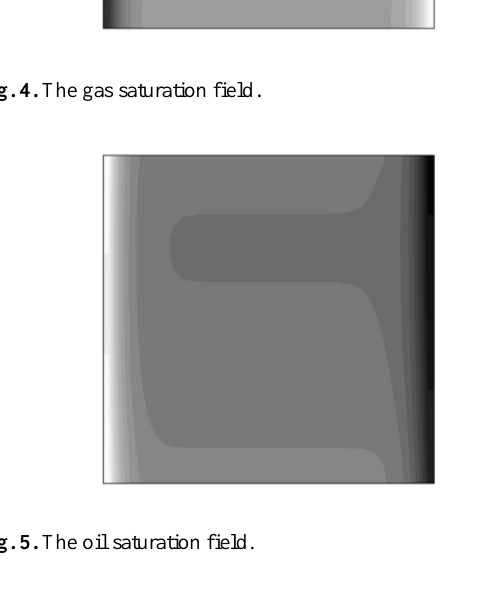
Fig. 4. The gas saturation field .